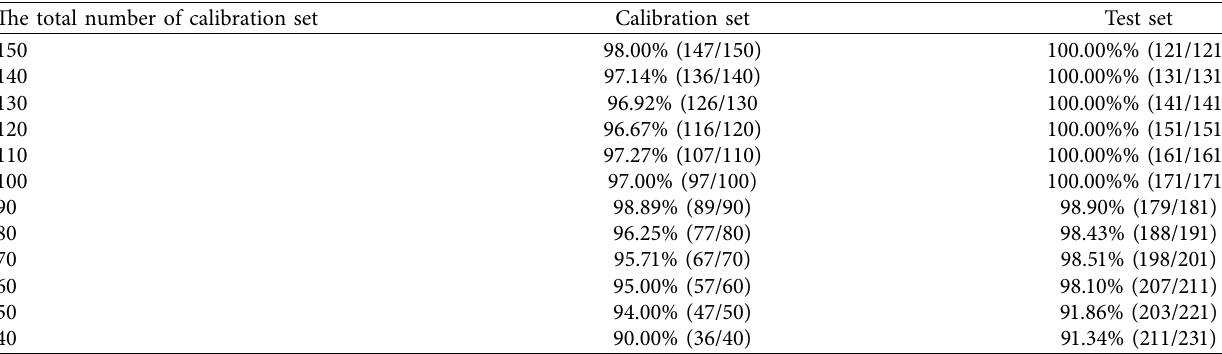
Table 6: The classification results of the calibration set and the test set based on the different number of samples in the calibration set by support vector machine.